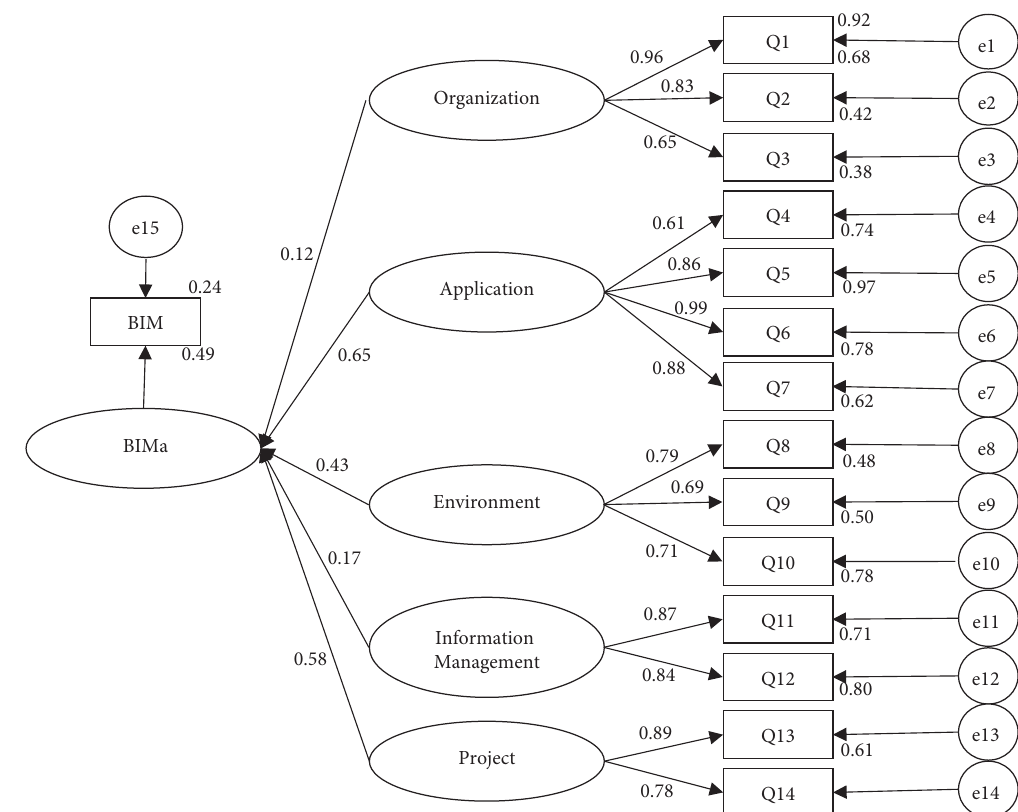
Figure 2: Structural model of the study.